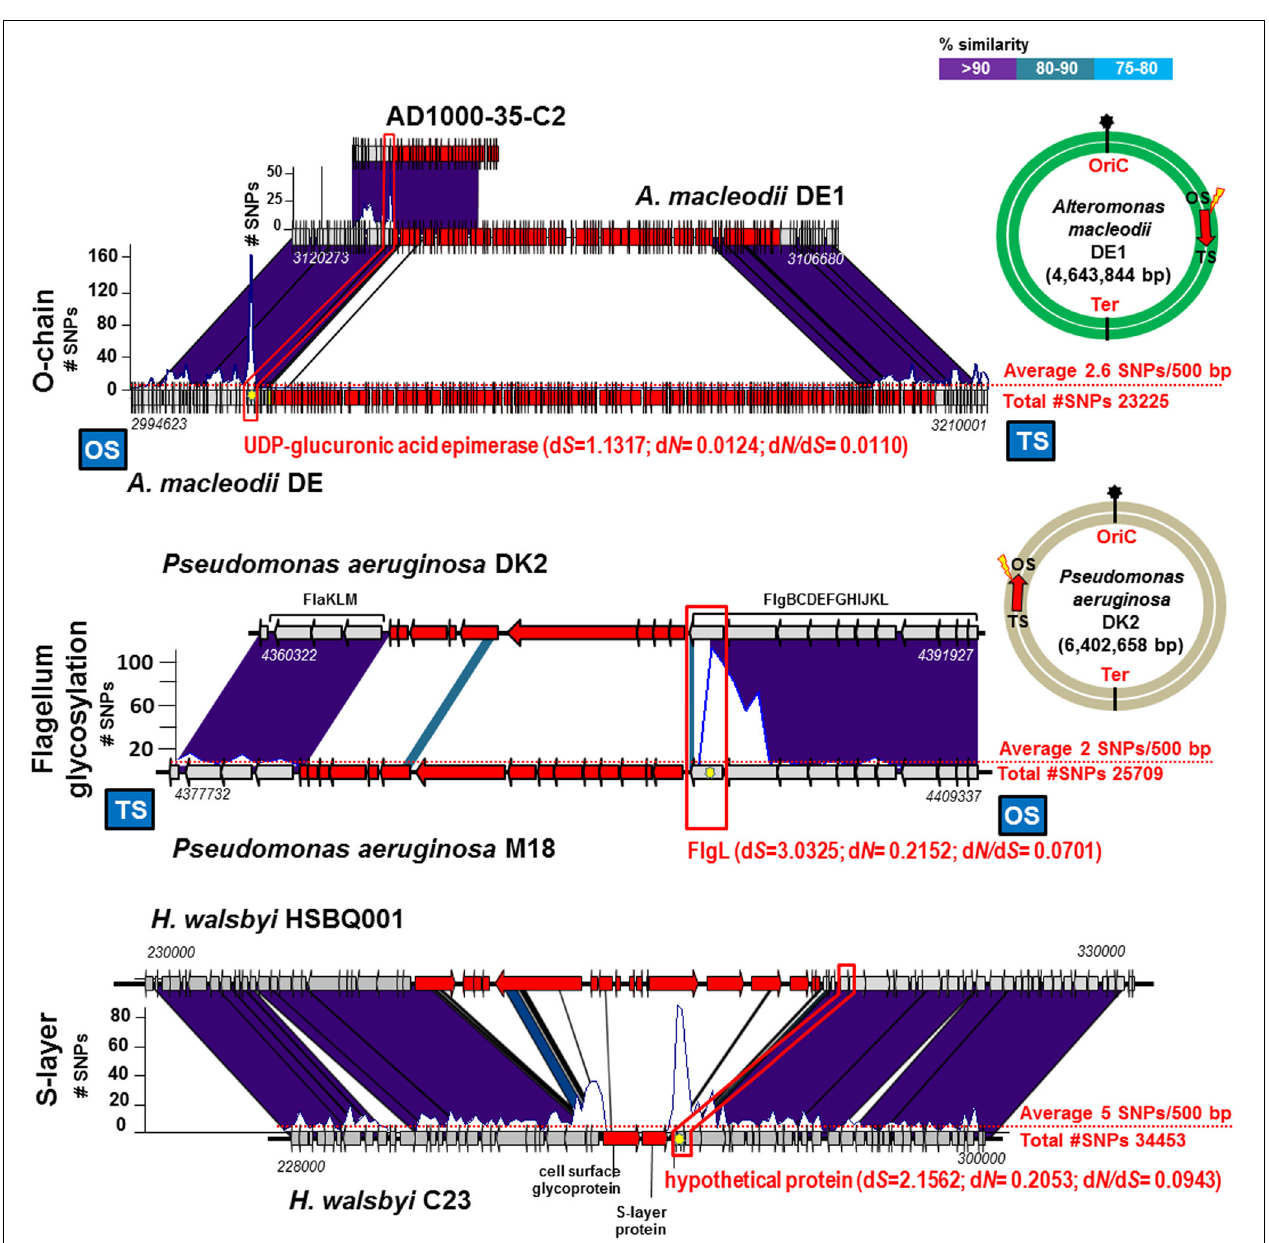
FIGURE 3 | Different versions of the same replacement fGI between pairs of strains of the same species. Designation of the fGI compared in each example are indicated to the left. Representation of the graphic is like in Figures 1 , 2